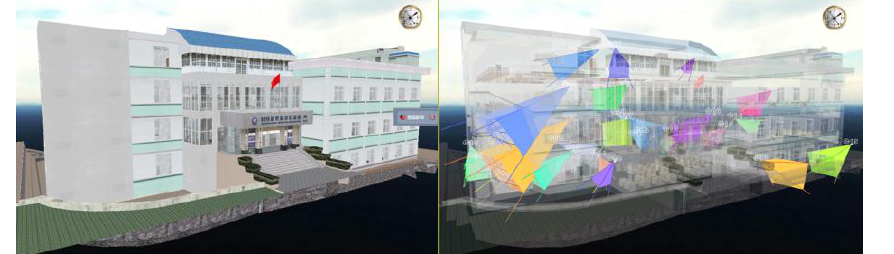
Figure 4. Logical storage model